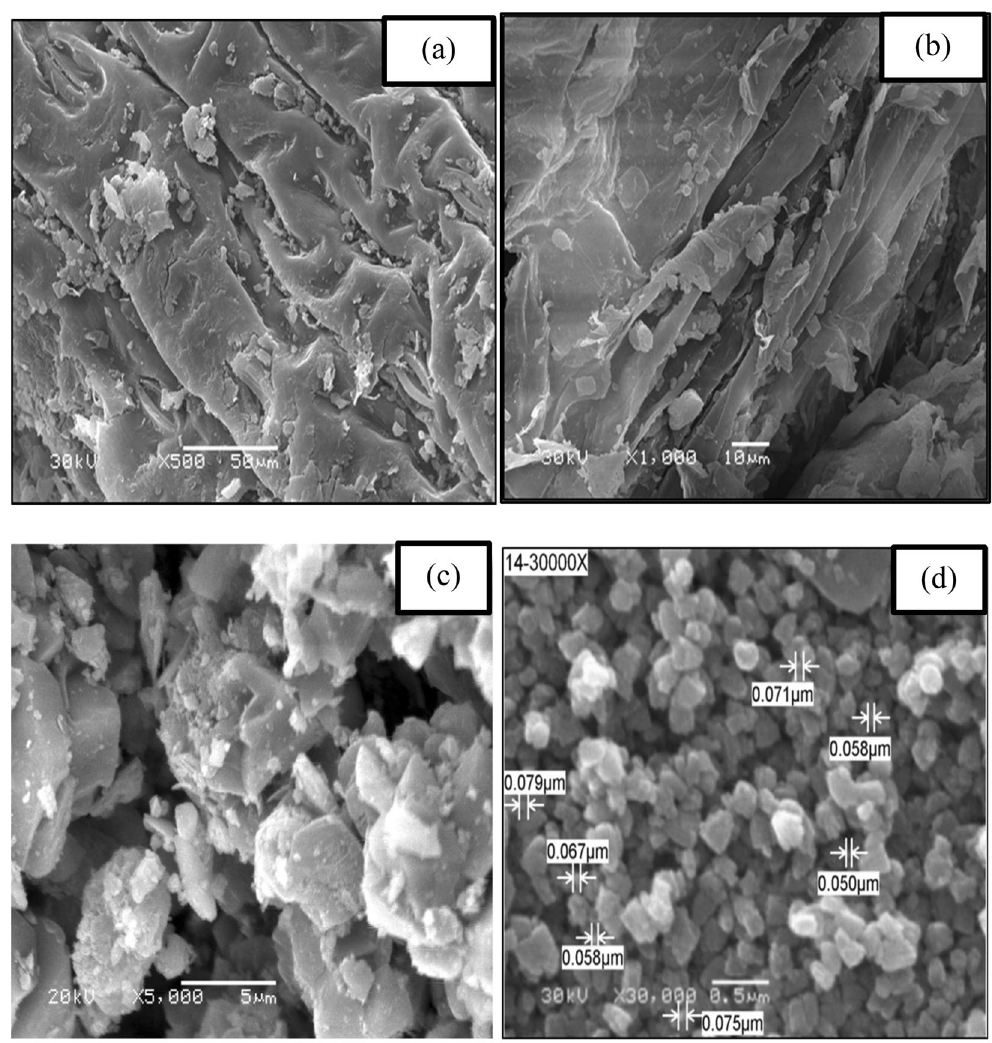
Figure 3. SEM micrographs of surface imaging ( a ) shoots segment of water hyacinth, ( b ) roots segment of water hyacinth, ( c ) prepared activated carbon, ( d ) magnetite immobilized activated